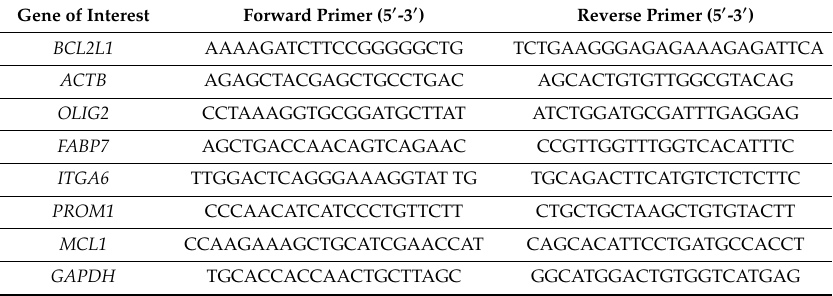
Table 1. List of specific primers used for